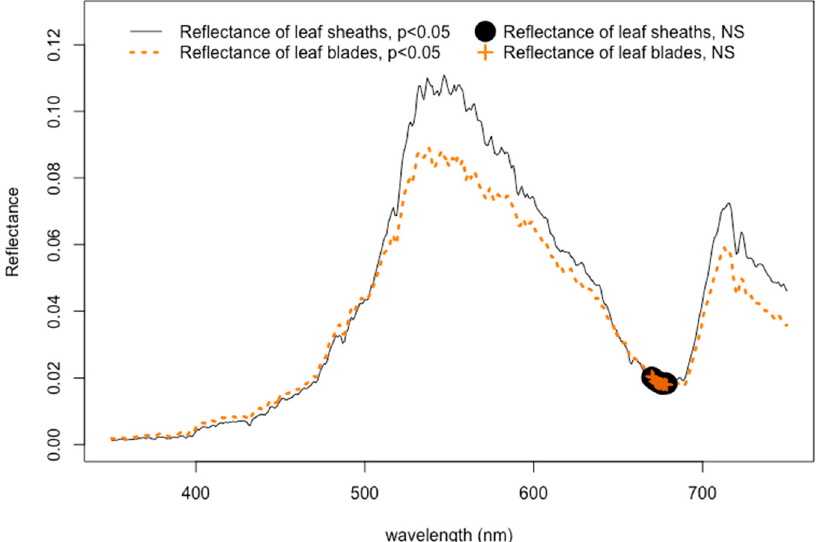
Figure 2. Spectral reflectance profiles for leaf blades and leaf sheaths of seagrass plants. Epiphytes are generally located on leaf blades found at the top of the plants.